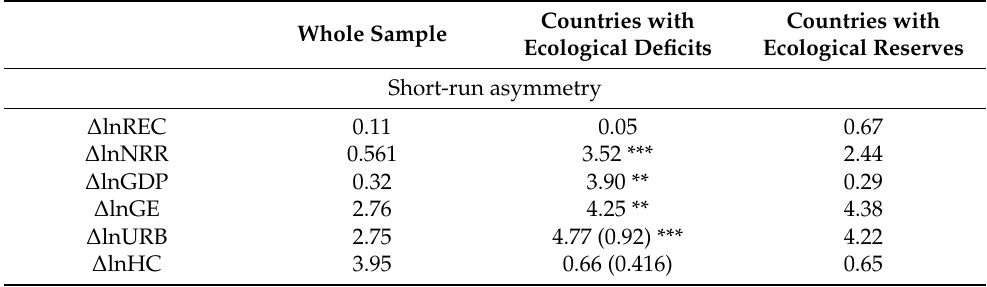
Countries with Ecological Reserves